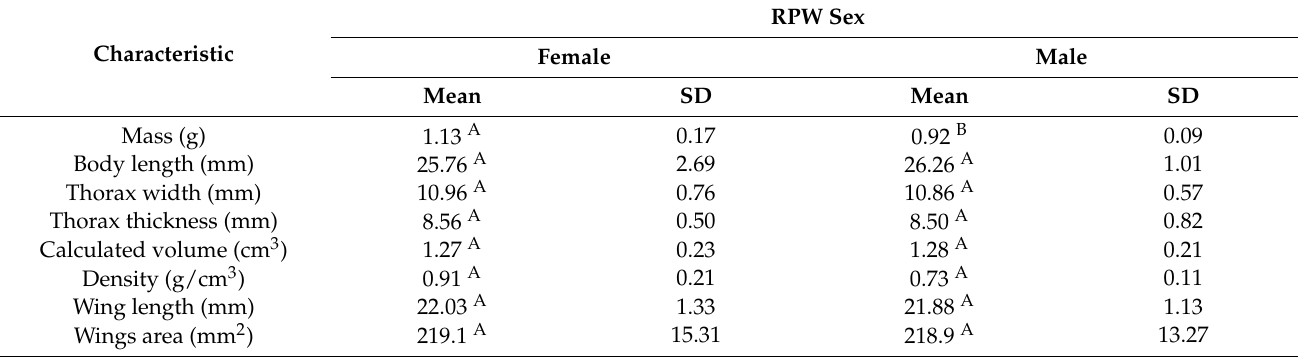
Table 1. Mean and standard deviation (SD) of some morphometric measurements of weevils used in the study.